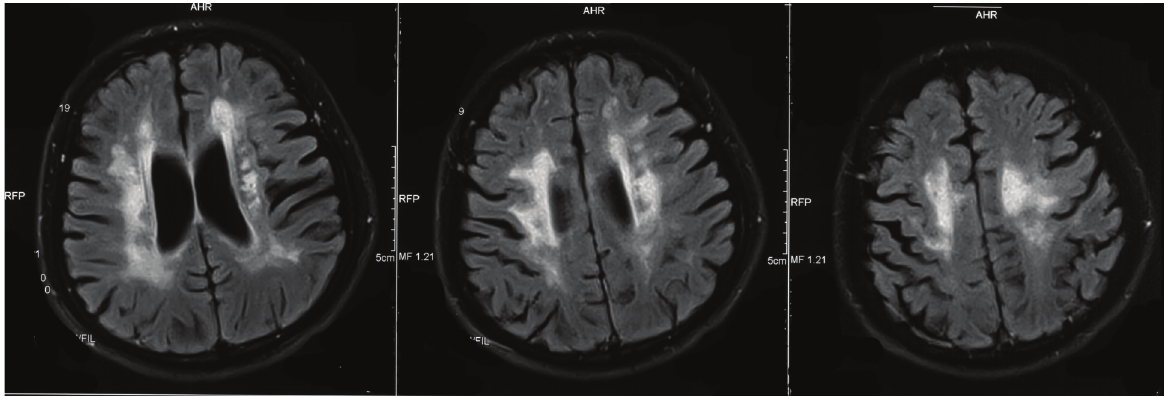
Figure 2. Head FLAIR and MRI images of the pro-band. Image shows bilateral lateral ventricles, bilateral semi-oval center with multiple abnormal signals, and demyelination in the white matter around the bilateral lateral